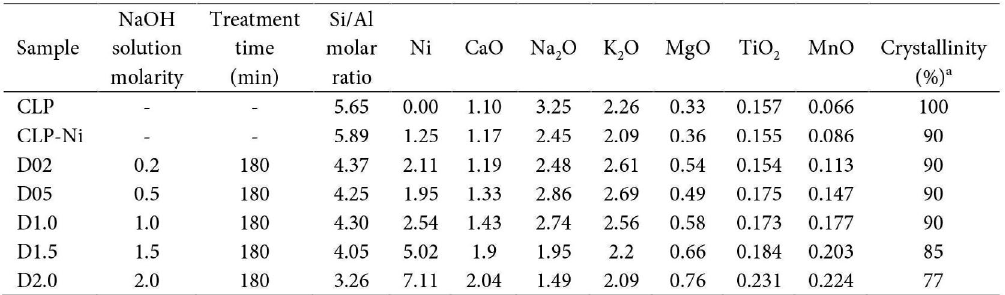
Table 1. Nomenclature of the Different Samples Based on their Preparation Procedure and their Chemical Analysis. Metal and Metal Oxides Concentrations are Expressed as wt.%